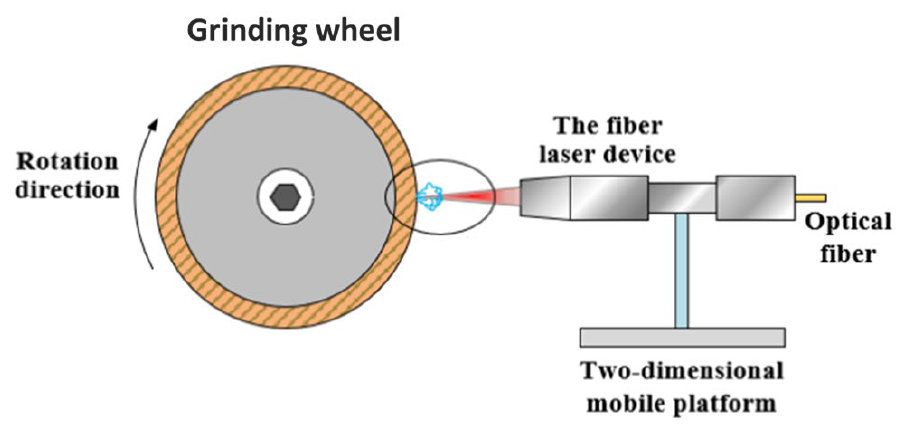
Figure 10. Experimental setup for laser structuring [81].